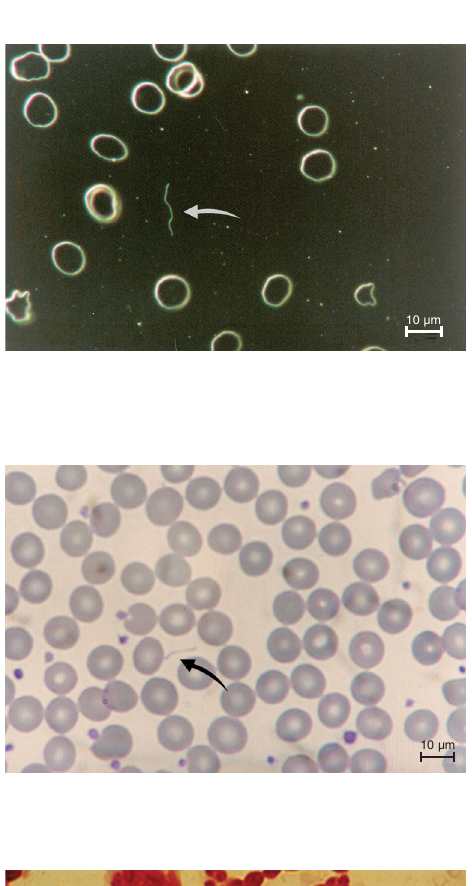
Figure 3. Cerebrospinal fluid of a patient with Lyme disease-like syndrome, with visualization of spirochetes (arrow; HE, 1000X, magnification bar = 10 µm).